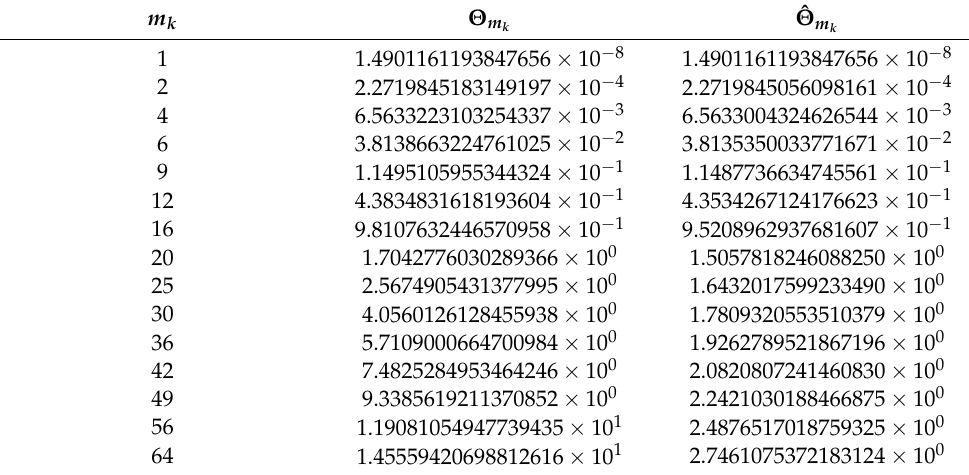
Table 1. Values of Θ m